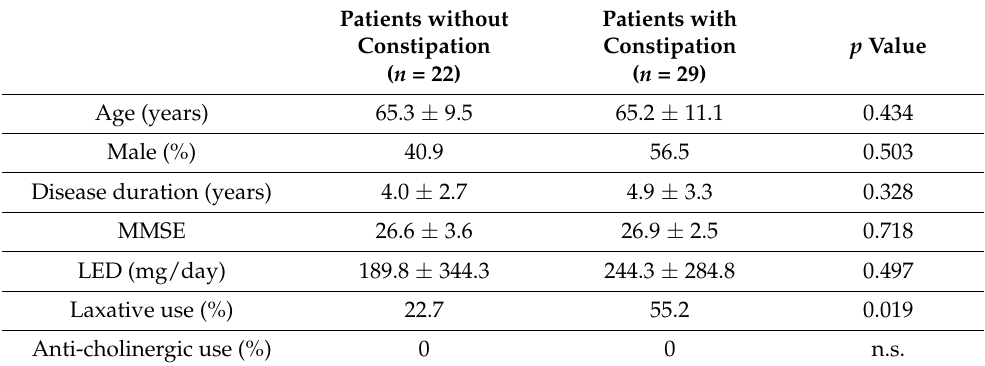
Table 1. Comparison of demographic and clinical characteristics among groups of multiple system atrophy patients with and without constipation.